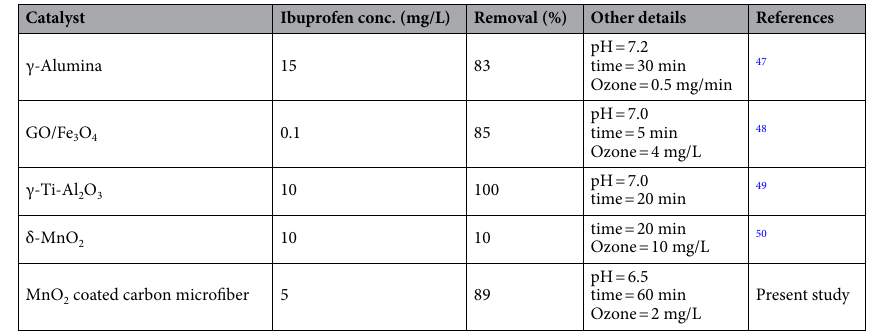
Table 2. Comparison of Ibuprofen removal using different catalytic ozonation process.